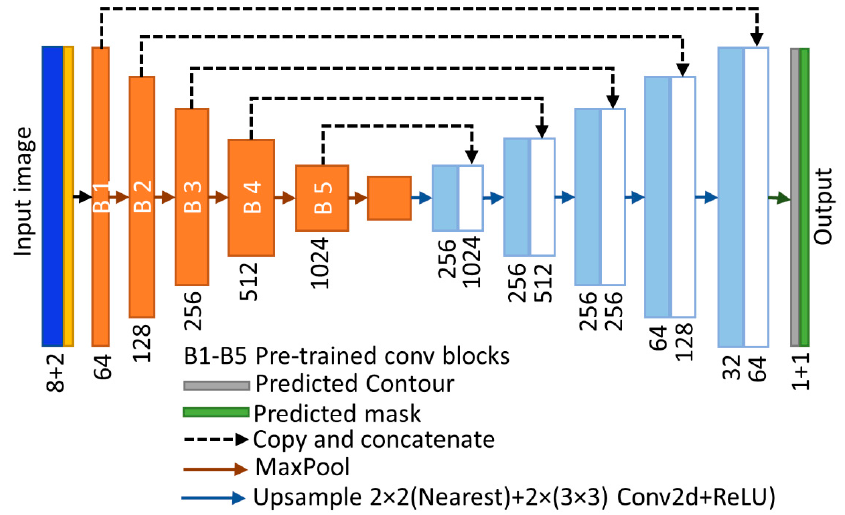
Figure 4. Schematic of the architecture used in our study. The numbers below the first and last bars showed the layers of images in model input and output, respectively. The numbers below the other bars showed the number of convolutional neural network (CNN) layers.